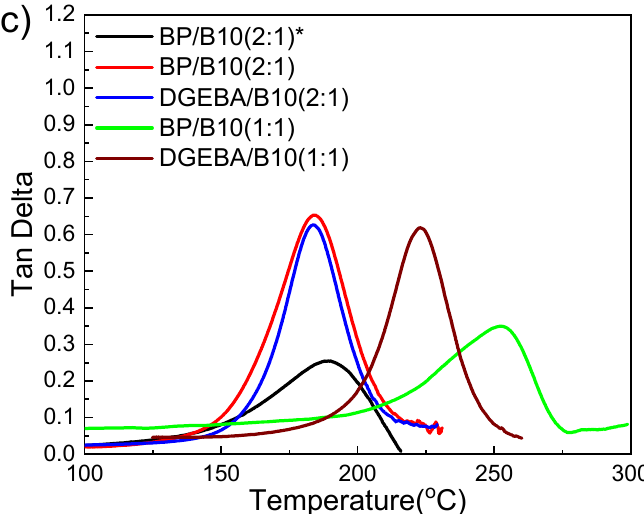
Figure 5. ( a ) Dynamic mechanical analysis (storage modulus), ( b ) dynamic mechanical analysis (loss modulus) and ( c ) dynamic mechanical analysis (tan delta) of cyanate ester (B10)-cured epoxy resin in epoxy:B10 = 2:1 (*: anisotropic).